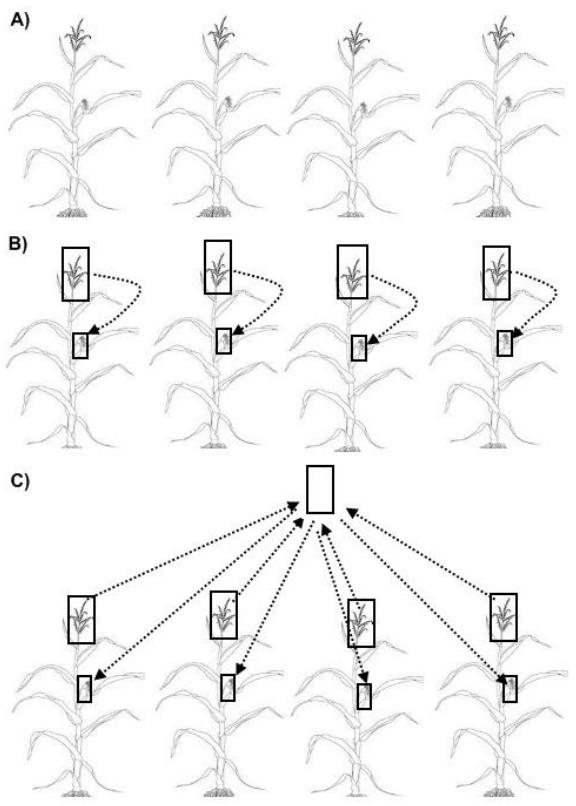
F IGURE 1. Graphical presentation of compared pollination methods: open pollination (A), self-pollination (B), and bulk pollination (C). Rectangular shapes indicate the pollination bags and shoot